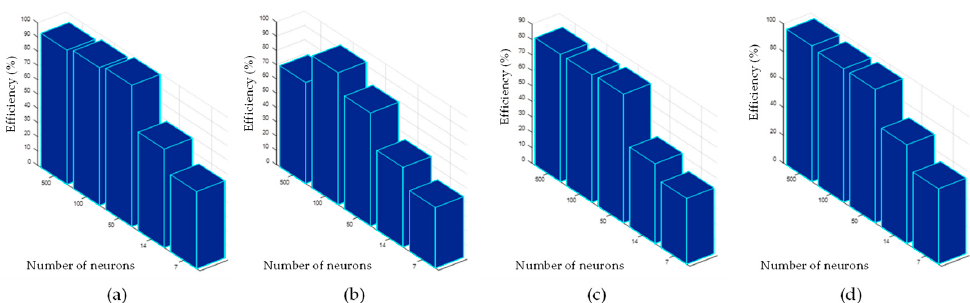
Figure 12. Influence of the number of radial neurons in the hidden layer on the effectiveness of the RBF-based fault detector for different spread values and input from FFT analysis and σ = 0.1 ( a ) , σ = 0.5 ( b ), ENV analysis and σ = 0.9 ( c ) , σ = 3 ( d ).